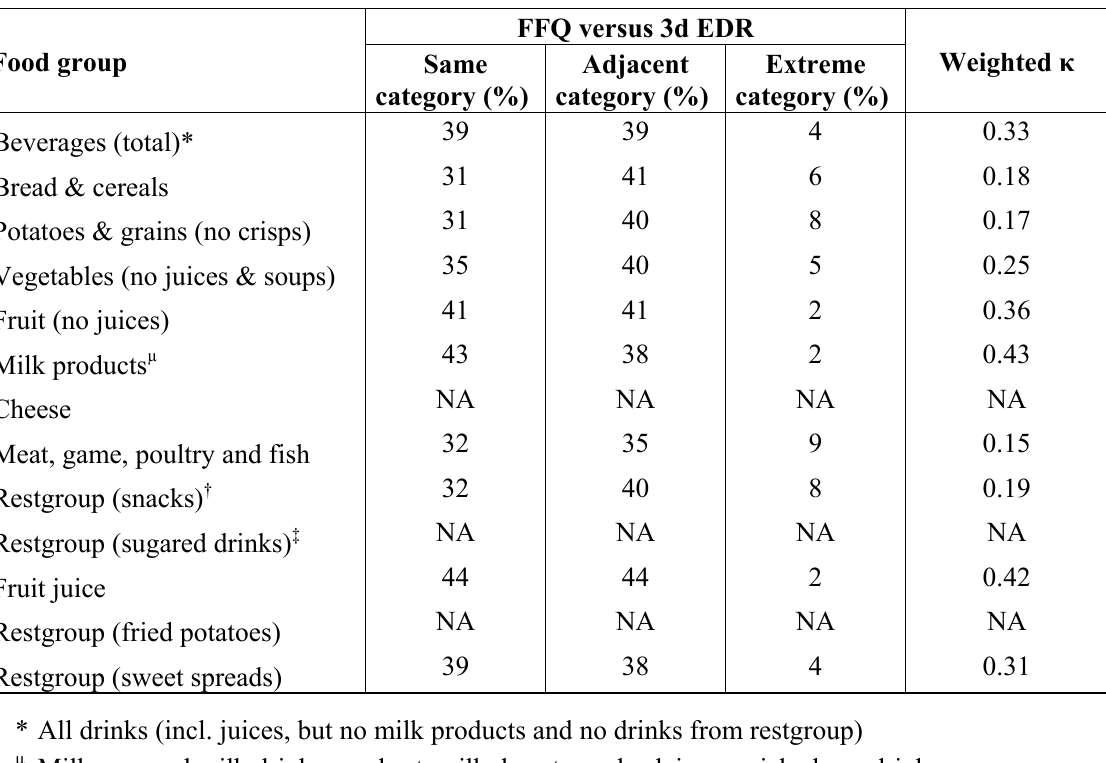
Table 6. Comparison of FFQ with mean daily intakes derived from 3d EDR, based on joint classification by